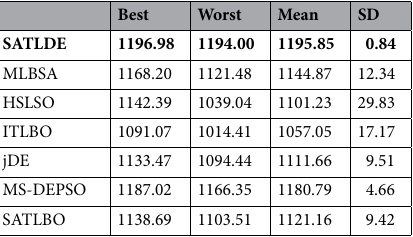
Table 2. Results of SATLDE algorithm and six other optimizers on four-reservoir system. Significant values are in bold.